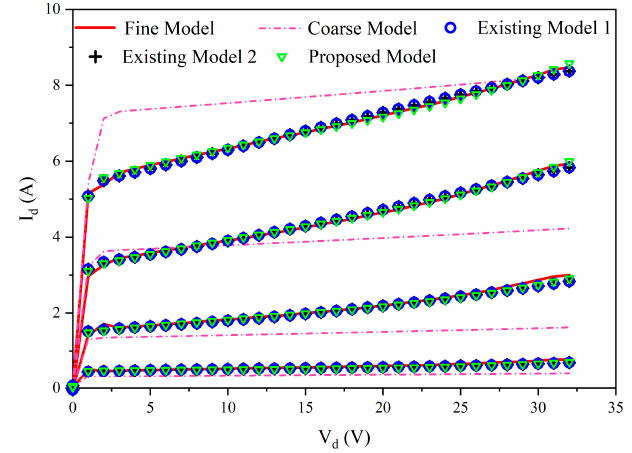
Figure 5. I–V comparison between the fine data and the models.